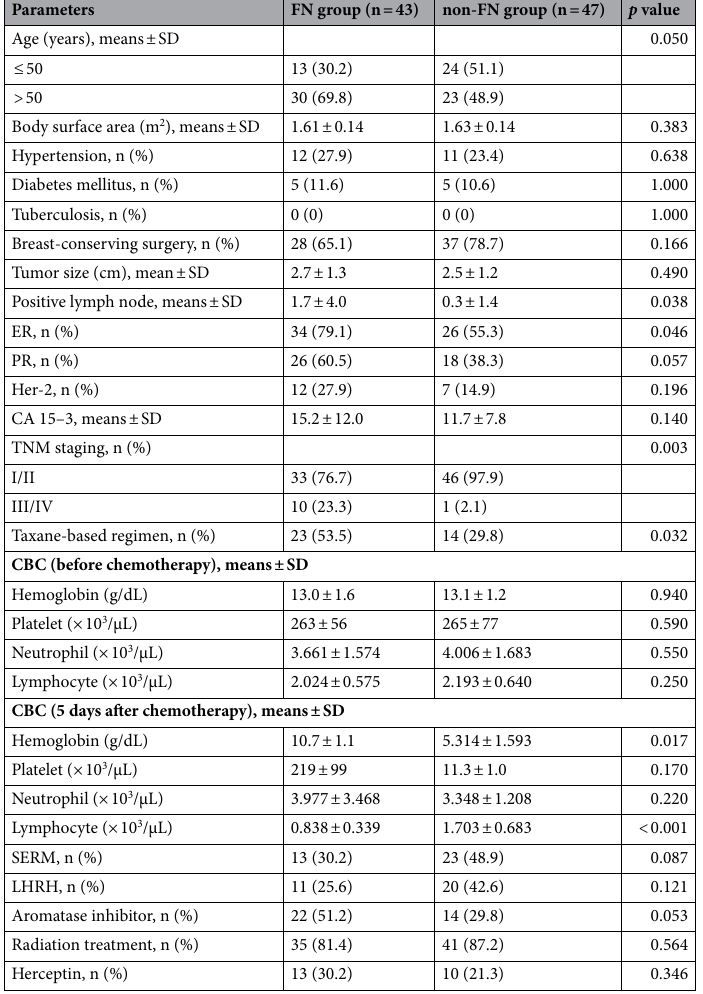
Table 2. Clinical demographic characteristics of patients with and without febrile neutropenia in the testing dataset. FN febrile neutropenia, SD standard deviation, ER estrogen receptor, PR progesterone receptor, Her-2 human epidermal growth factor receptor 2, CA cancer antigen, CBC complete blood count, SERM selective estrogen receptor modulator, AI aromatase inhibitor, LHRH luteinizing hormone-releasing hormone, F/U